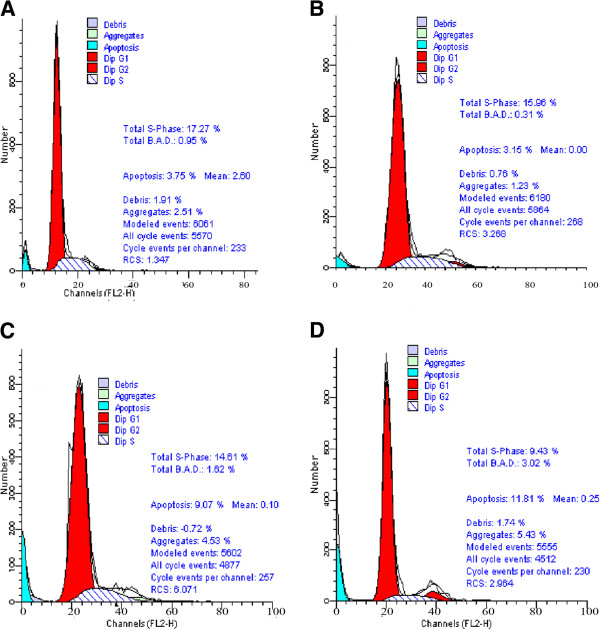
SATB1- siRNA induced NCI-H446 cells apoptosis after transfected with SATB1- SiRNA-1, SATB1- SiRNA-2, SATB1- siRNA-N, result showed by absorption value of PI stain at 24–96 hours.